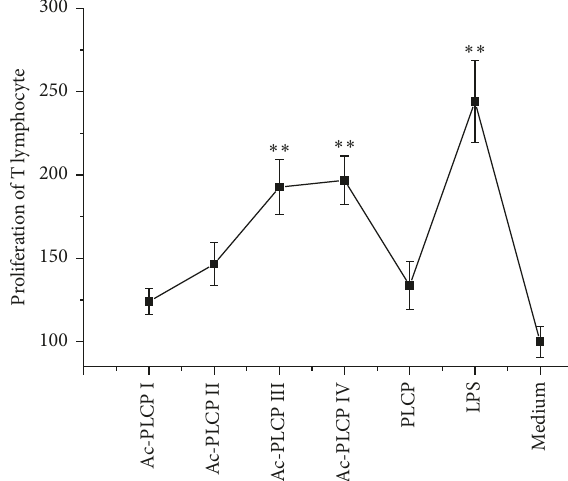
Figure 6: DCs treated with Ac-PLCPs showed stronger activity on stimulating T lymphocyte proliferation. T lymphocytes were obtained from C57BL/6 (H-2K d and I-A d ) mice and cocultured with DCs in 96-well plate at the ratio of 10: 1 for 48 h. The absorption value of the medium group was set at control values in the calculation of % proliferation. All the polysaccharide-treated DCs showed extremely strong T cell proliferation stimulating